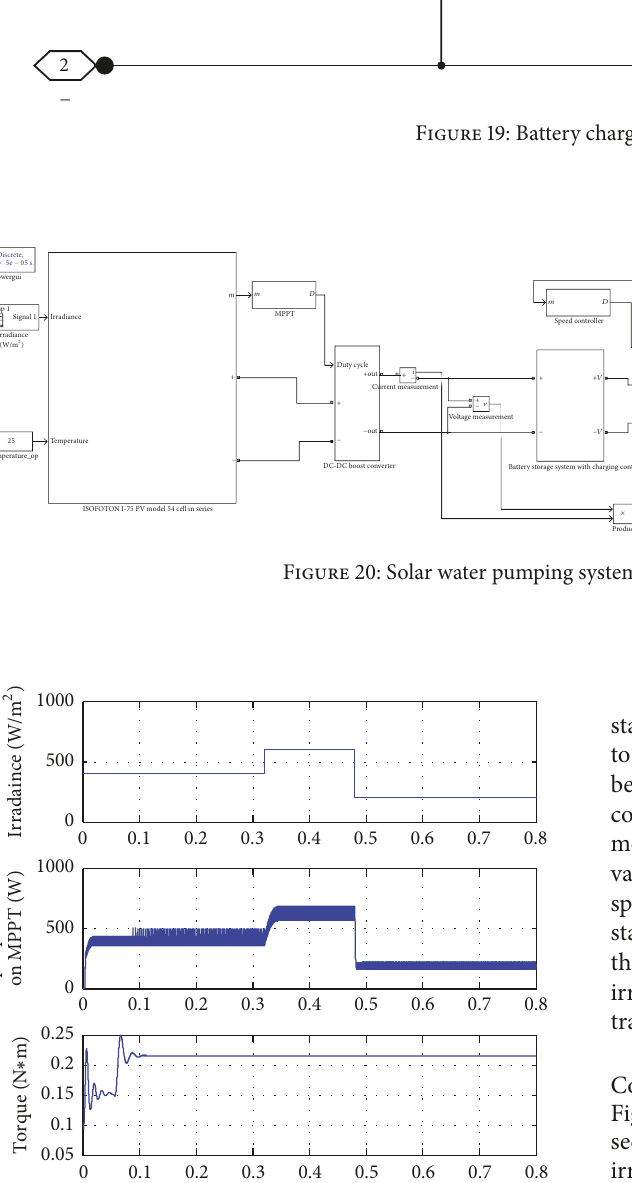
Figure 21: PV power and PMDC torque at various solar irradiation